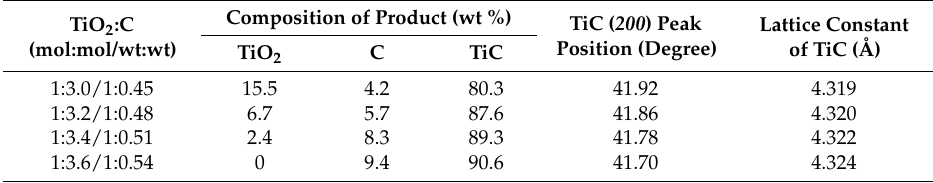
Position (Degree)